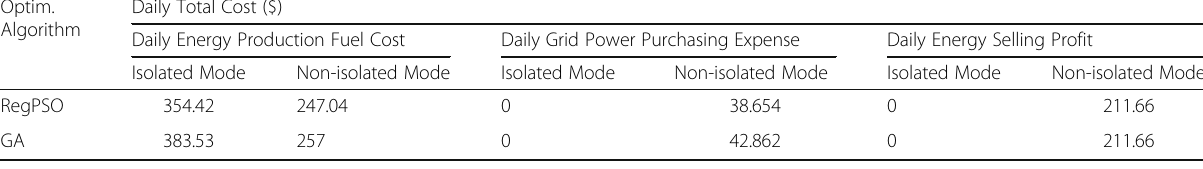
Table 2 Computation time for RegPSO and GA Optimization